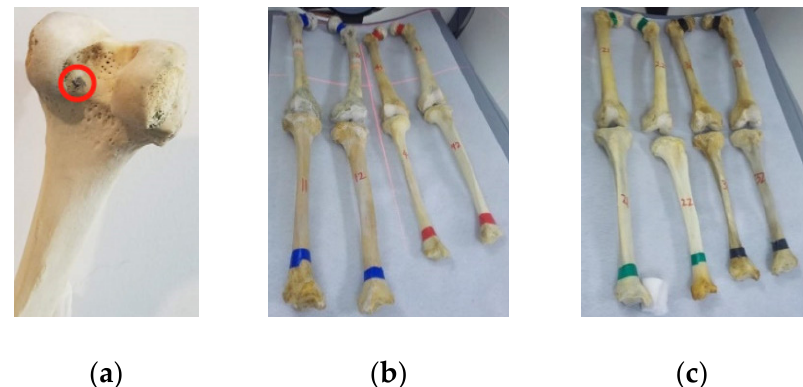
Figure 16. Dry bones for ACL navigation system: ( a ) Target on the femur: steel ball, marked with red circle, was embedded at both ends of the tunnels; ( b ) 2 pairs of dry cadaver femur and tibia (No.1 and No.4); ( c ) 2 pairs of dry cadaver femur and tibia (No.2 and No.3).